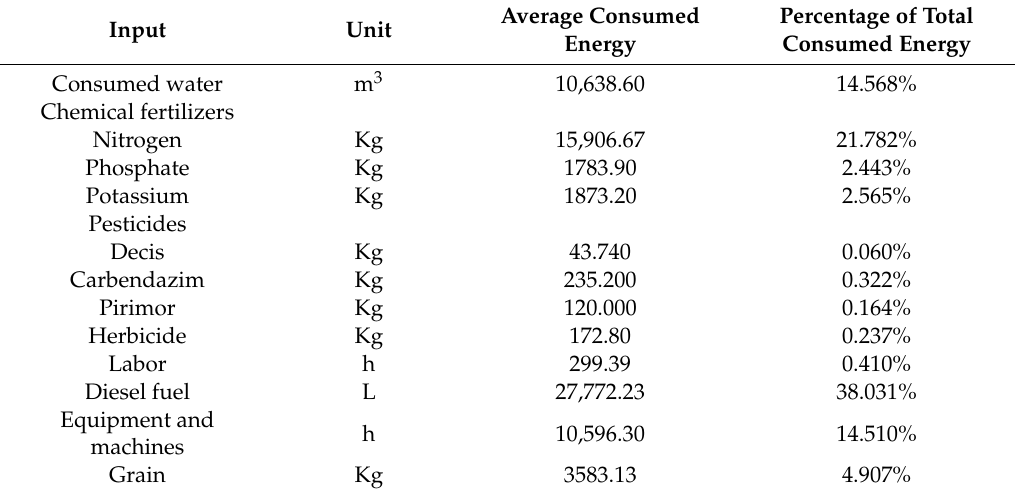
Table 4. Input energy.